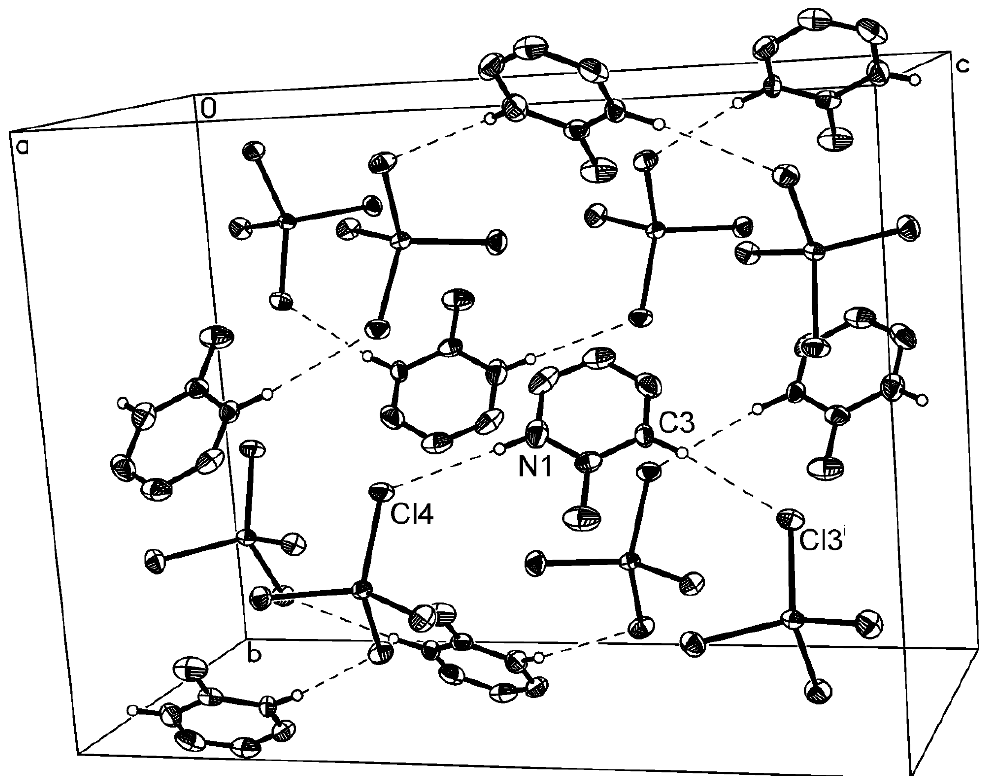
Figure 2. The crystal packing of [2-Me(Py)H][FeCl ]. The N–H … Cl and C–H … Cl hydrogen bonds are represented by dashed lines. The displacement 4 ellipsoids are drawn at the 25% probability level, and H–atoms not involved in interactions were omitted for